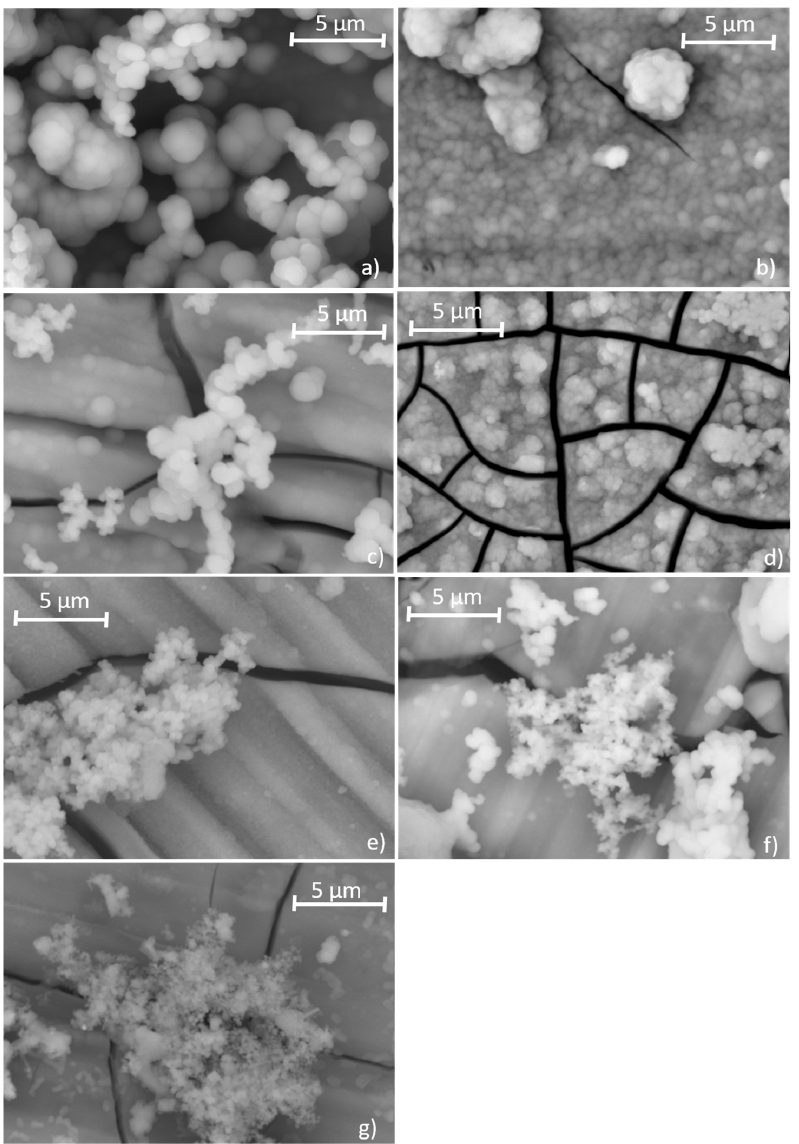
Figure 11. SEM images of the Ca, P-rich compounds on ( a ) pure Mg ( b ) Mg-0.38Ga-1.5Zn, ( c ) Mg- 1.12Ga-1.5Zn, ( d ) Mg-0.75Ga-3Zn, ( e ) Mg-0.38Ga-4.5Zn, ( f ) Mg-1.12Ga-4.5Zn and ( g ) Mg-1.5Ga-6Zn alloys after 168 h immersion in SBF.